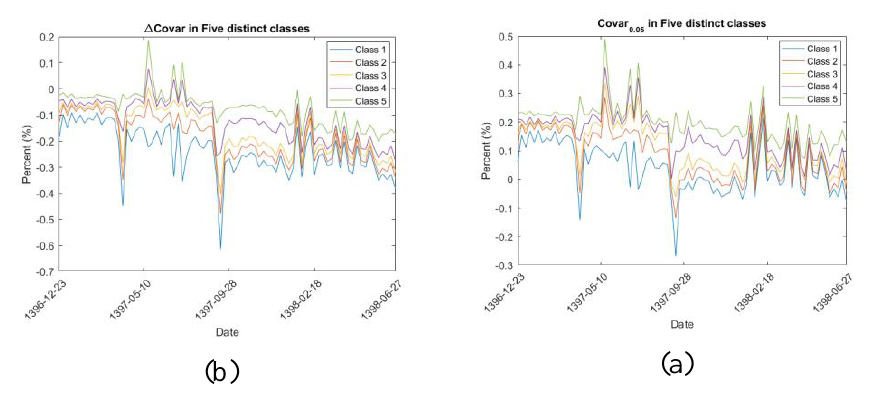
Figure 4. The Graphs of a) Mean CoVaR in the Five Groups, and b) Mean ΔCoVaR in the Five